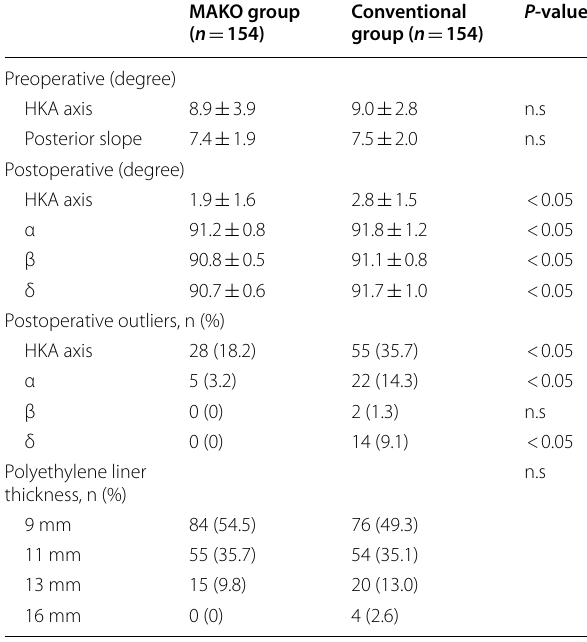
HKA hip-knee-ankle, α coronal inclination of the femoral component, β coronal inclination of the tibial component, δ sagittal inclination of the tibial component, n.s. not significant